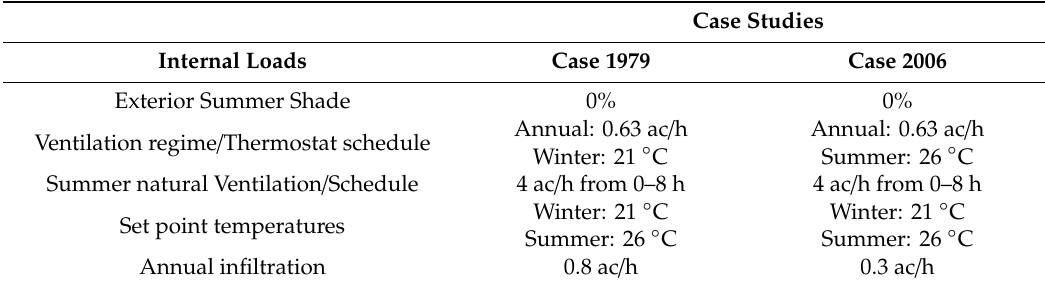
Table 6. Internal loads of the building